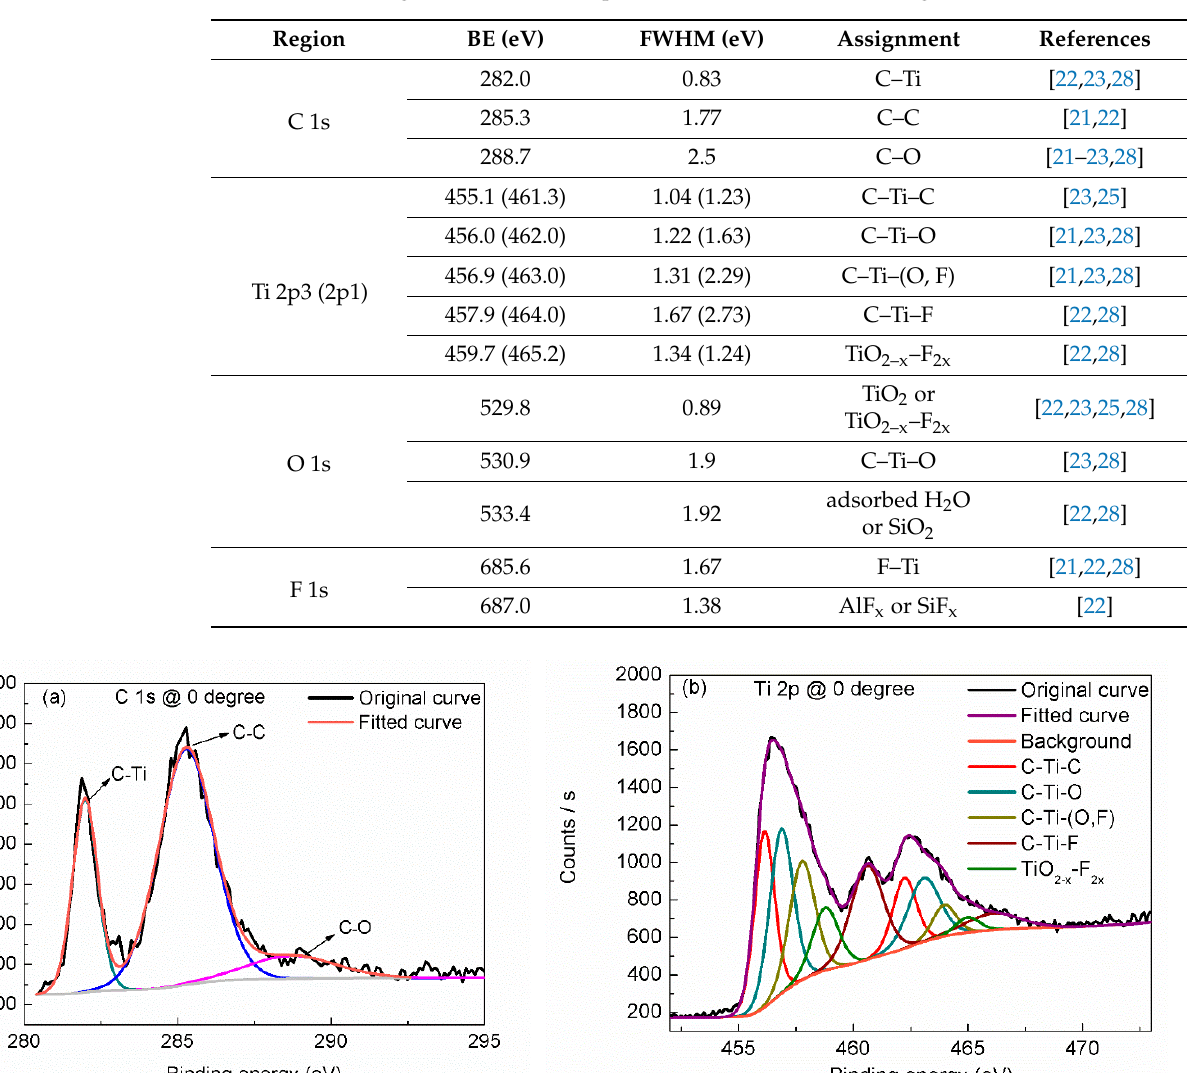
Table 1. Peak-fitting results of C 1s, Ti 2p, O 1s and F 1s narrow scanning’s.